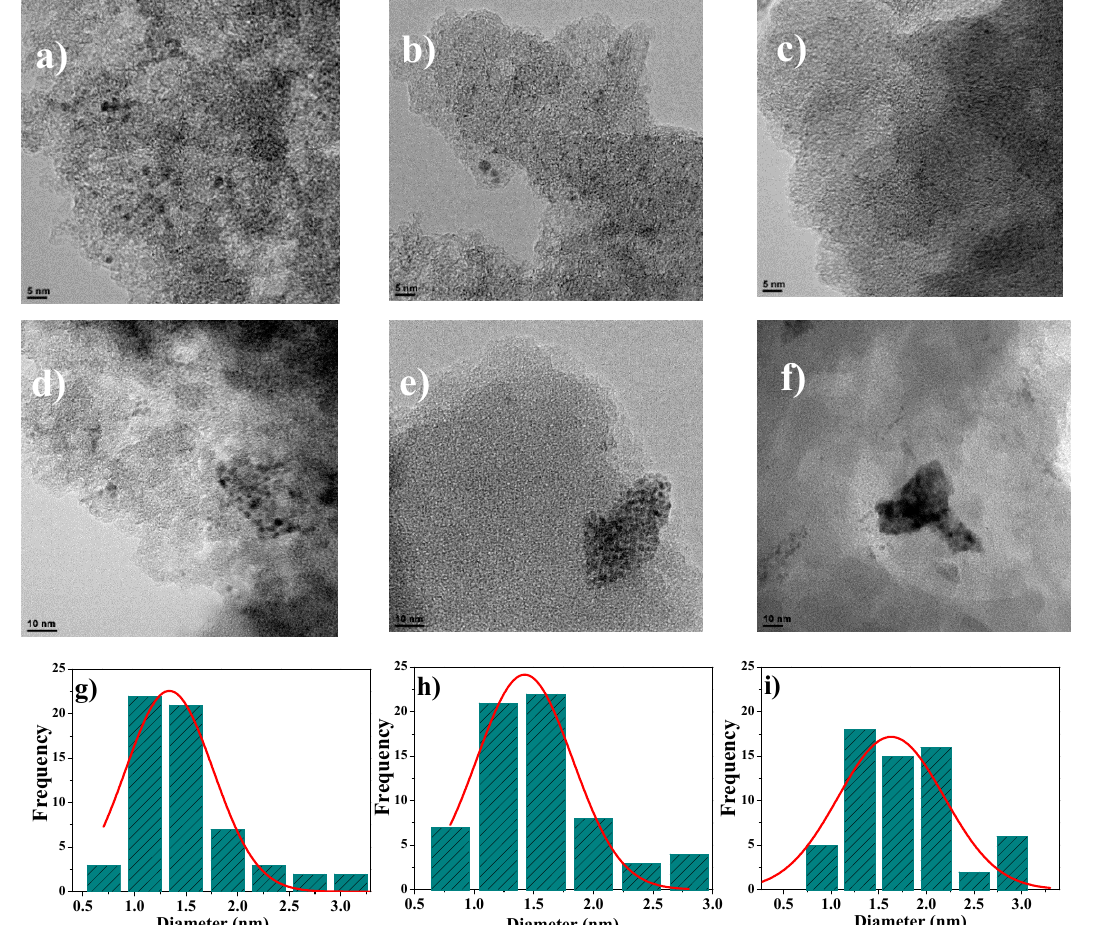
Figure 5. TEM images and Ru particle size distribution of catalysts: Ru/SA ( a ), ( d ) and ( g ); Ru/SASu ( b ), ( e ) and ( h ); and Ru/SAS ( c ), ( f ) and ( i ).